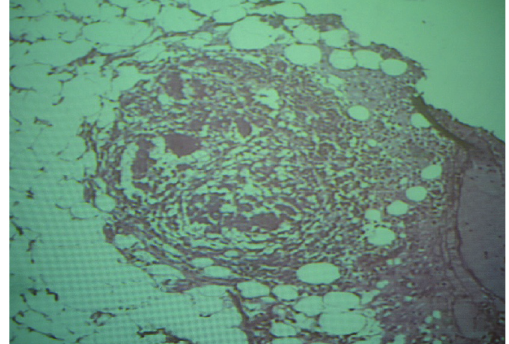
Figure 2: Microscopic picture showing chronic granulomatous inflammation with epitheloid histiocytes and Langhans type multi- nucleated giant cells (Case 2).